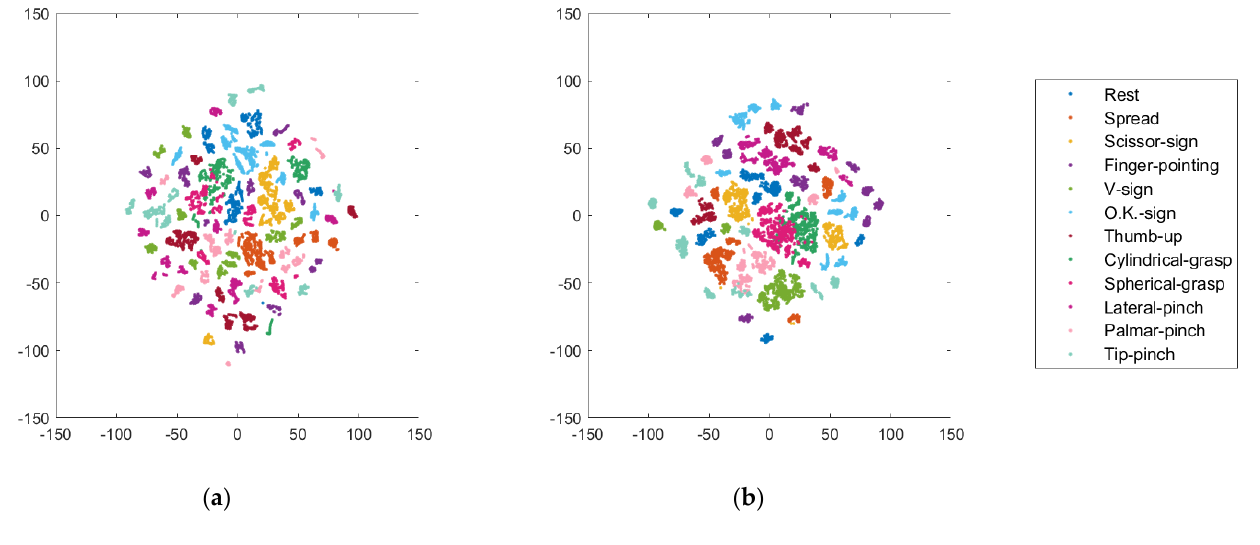
Figure 6. t-SNE visualization of variability in the sEMG signals of a healthy adult (subject 1): ( a ) Day 1, ( b ) Day 2.